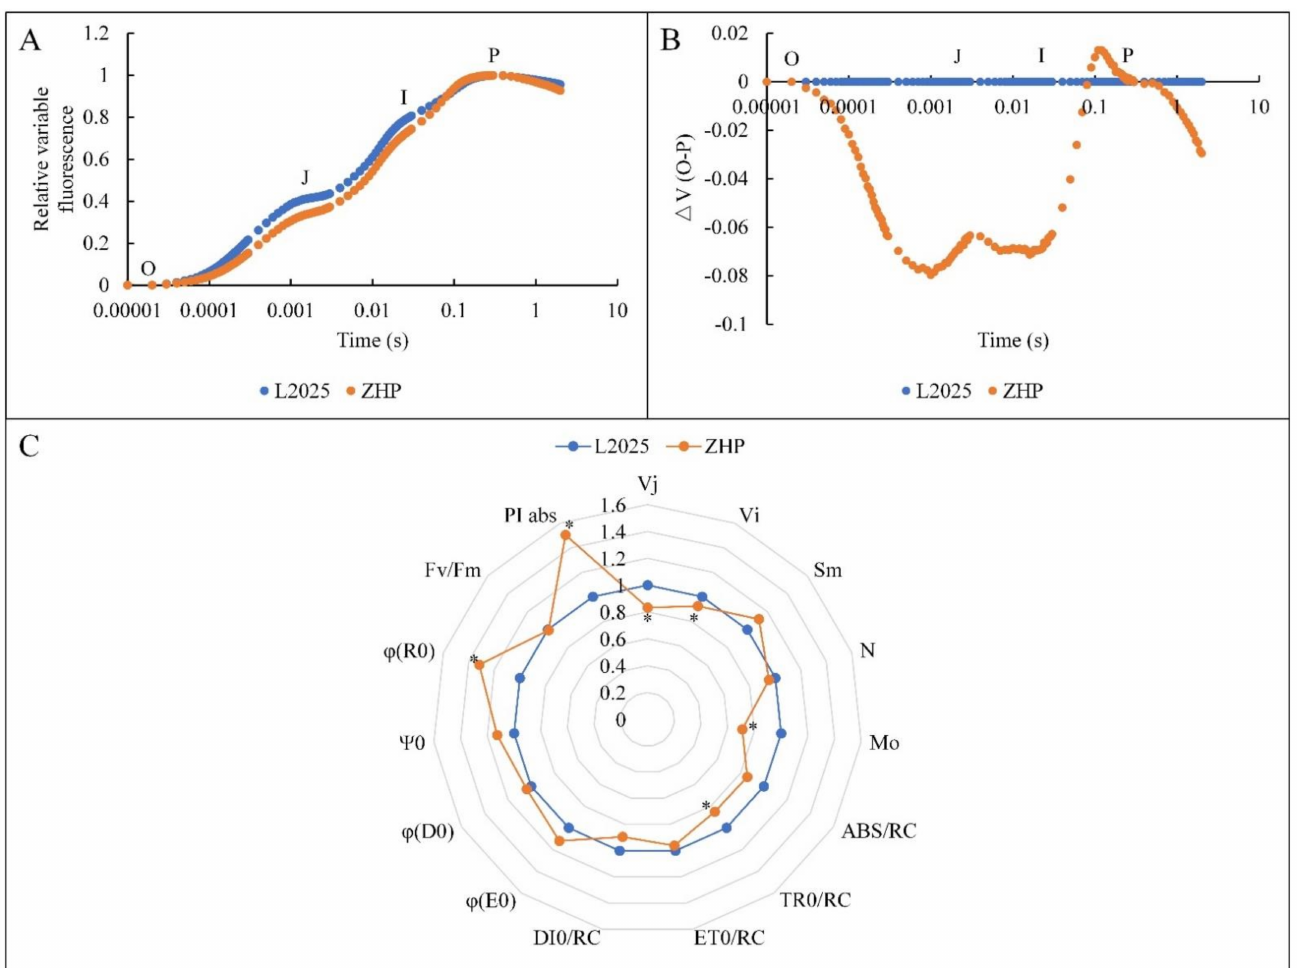
Figure 5. Changes in ( A ) standardized fluorescence intensity, ( B ) standardized variable fluorescence difference ( ∆ V), and ( C ) Chl a fluorescence parameter from leaves between ‘L2025’ and ‘ZHP’. Data are means ± SE ( n = 4). Values followed by * indicate significant difference according to Student’s t -test ( p <